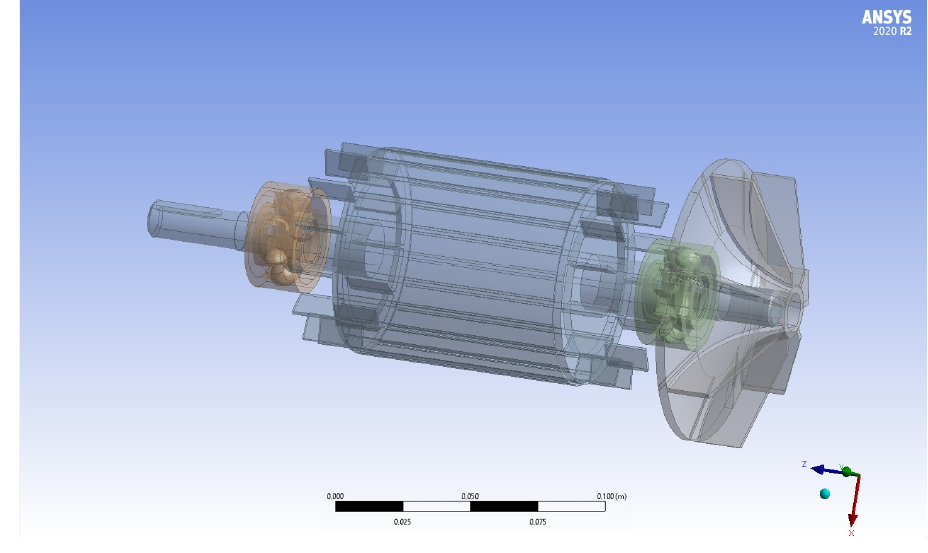
Figure 14. Assembling imported models in Ansys—Design